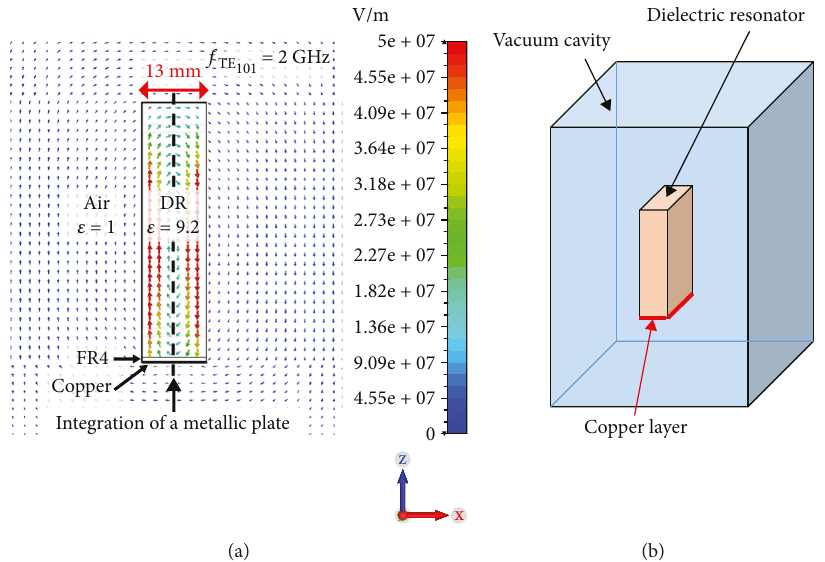
Figure 3: (a) E- fi elds on the y = 11 mm plane of an isolated DRA placed on a FR4 substrate coated by copper. (b) Integrating a vacuum cavity surrounded by PMC conditions during eigenmode analyses.